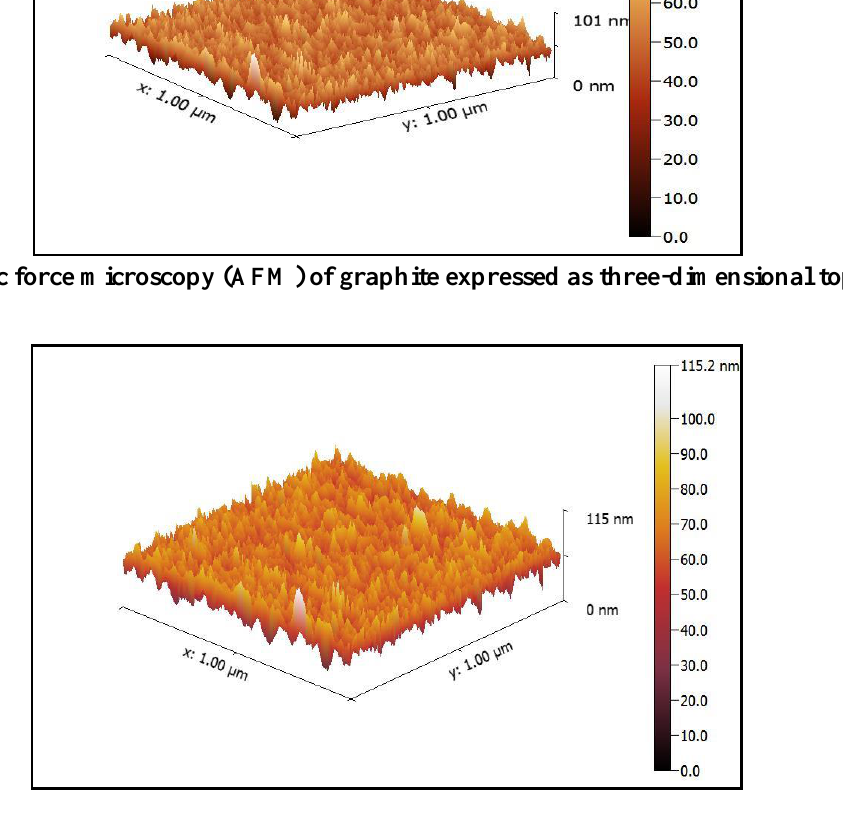
Fig. 5 . Atomic force microscopy (AFM) of graphene oxide expressed as three-dimensional topgraphy .